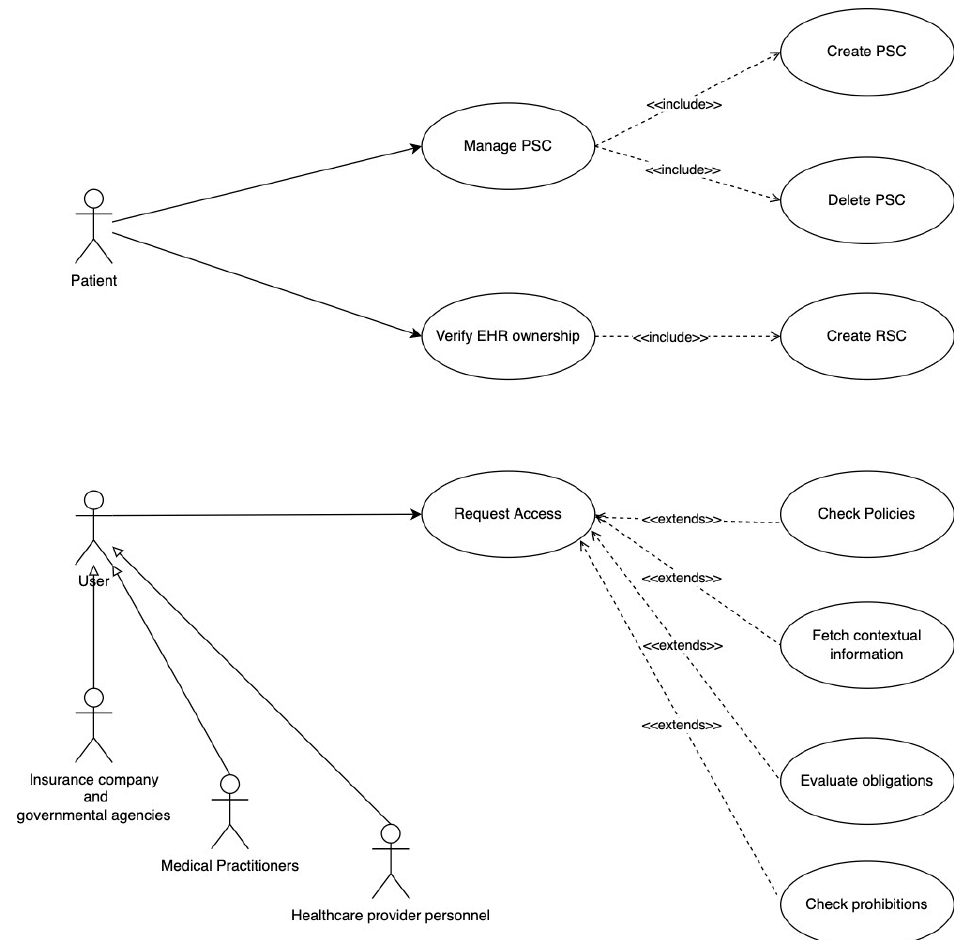
Figure 4. Use Cases of Access Control in GHPE.